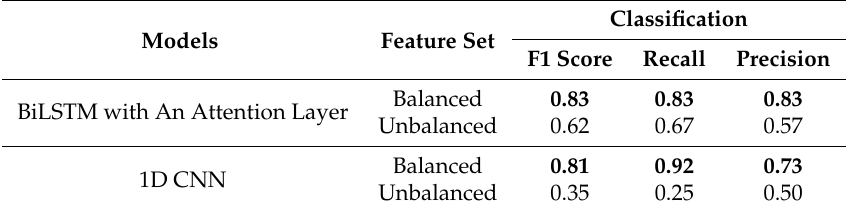
Table 6. Performance of different features before and after data